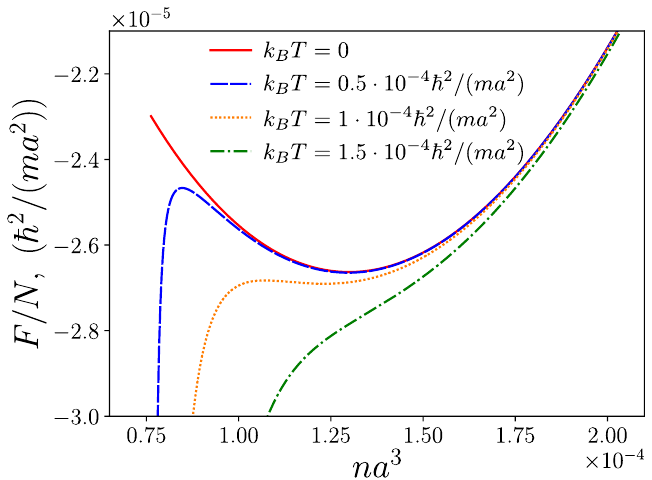
Figure 8: Free energy per particle of a 3D liquid Eq. (22) as a function of density for δ g / g = − 0.2 at different